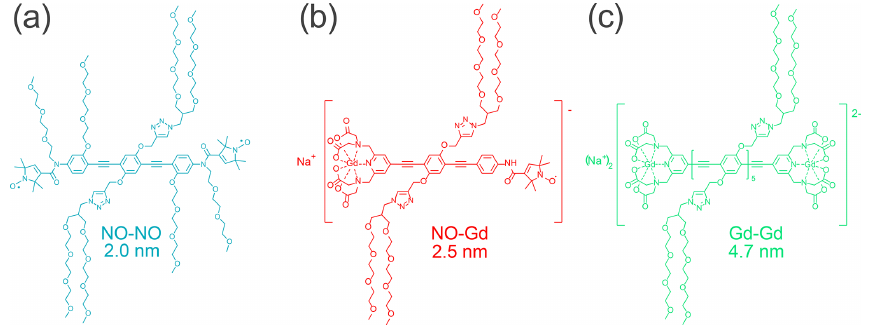
Figure 1. Structural formulae of the NO–NO, NO–Gd, and Gd–Gd rulers. Indicated are the experimentally detected mean distances between the paramagnetic centers.